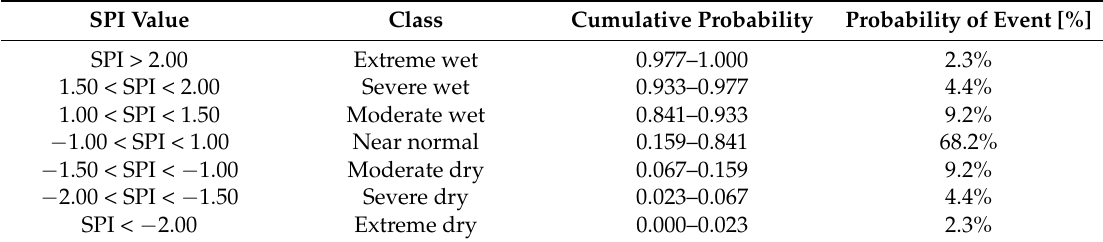
Table A1. SPI classification following McKee et al. [8].